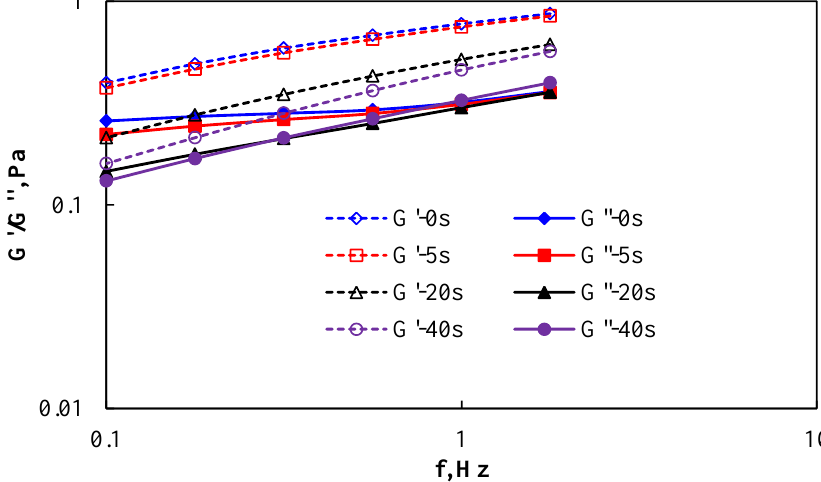
Figure 3. Effect of shear on the viscoelasticity of AP-P4 at a concentration of 2000 mg/L